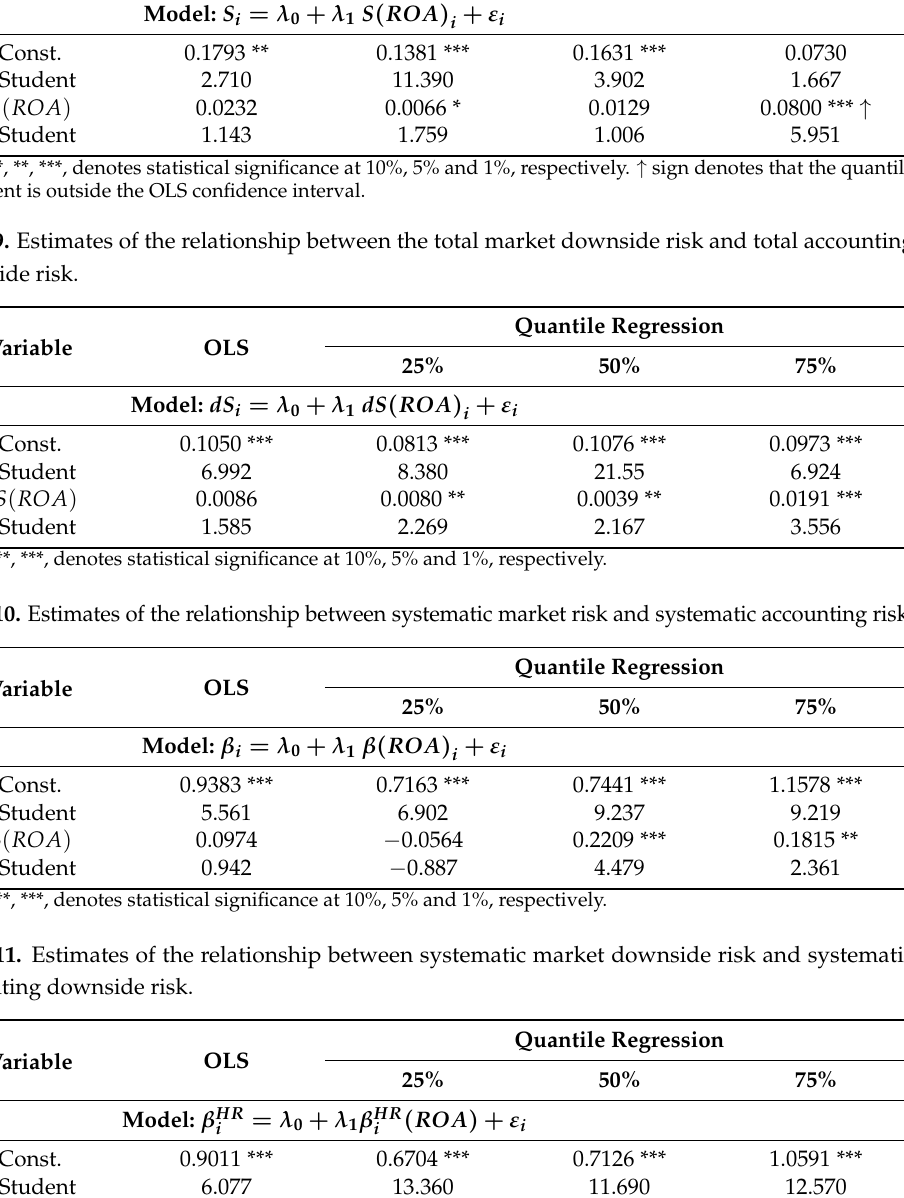
Table 8. Estimates of the relationship between total market risk and total accounting risk. Variable